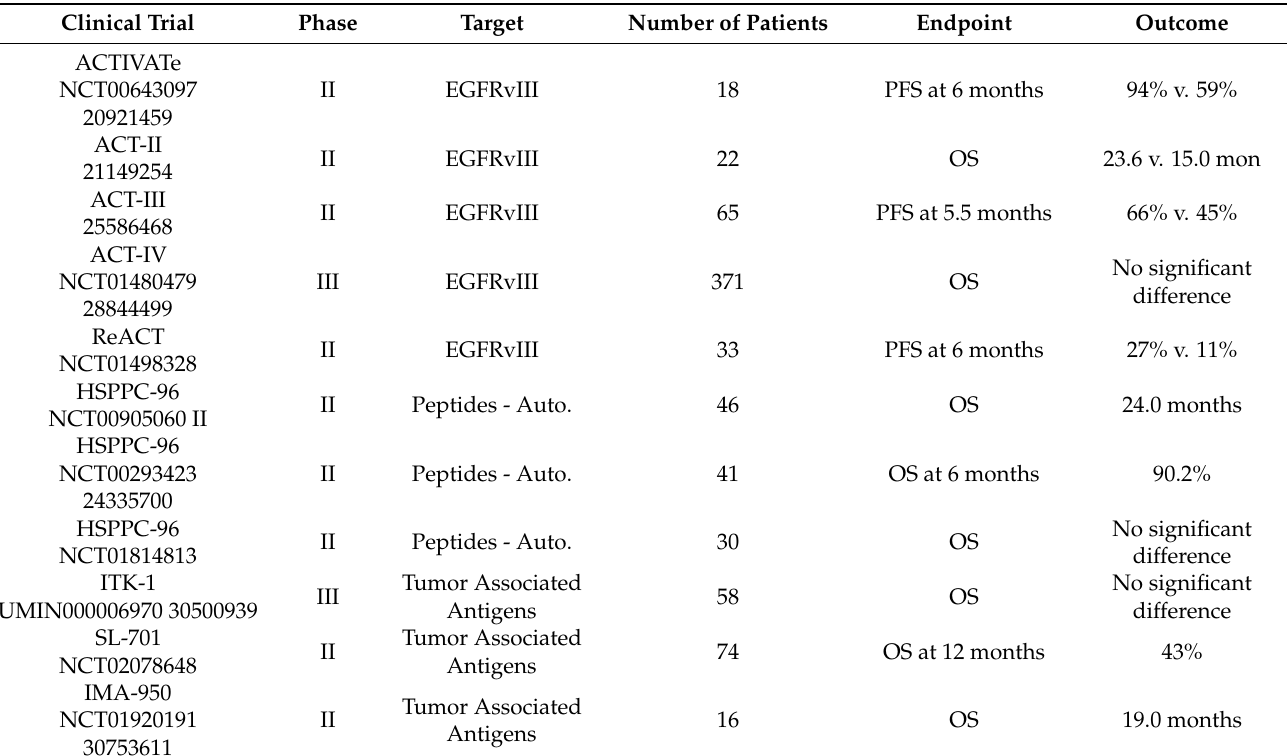
Table 1. Clinical glioblastoma peptide vaccine trials. Autologous Peptides (Peptides—Auto.); Progression Free Survival (PFS); Overall Survival